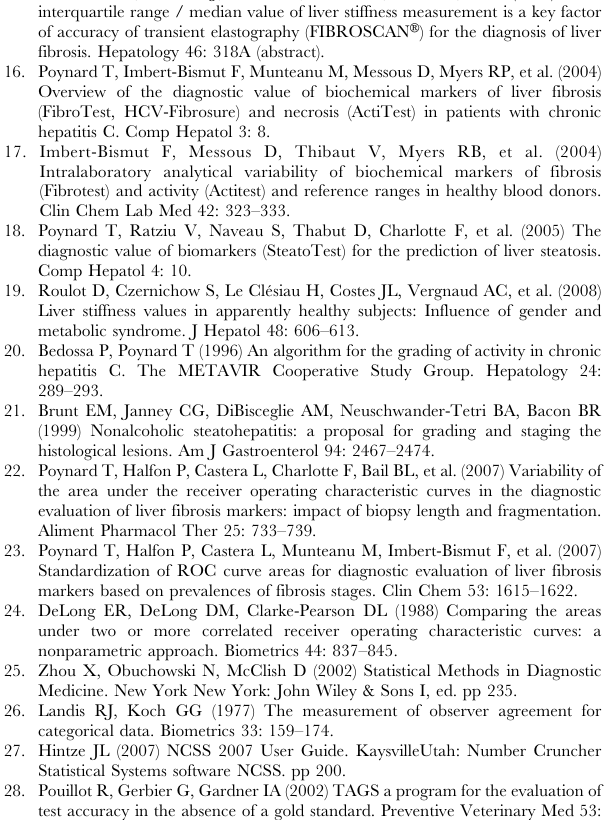
Table S5 Discordant cirrhosis